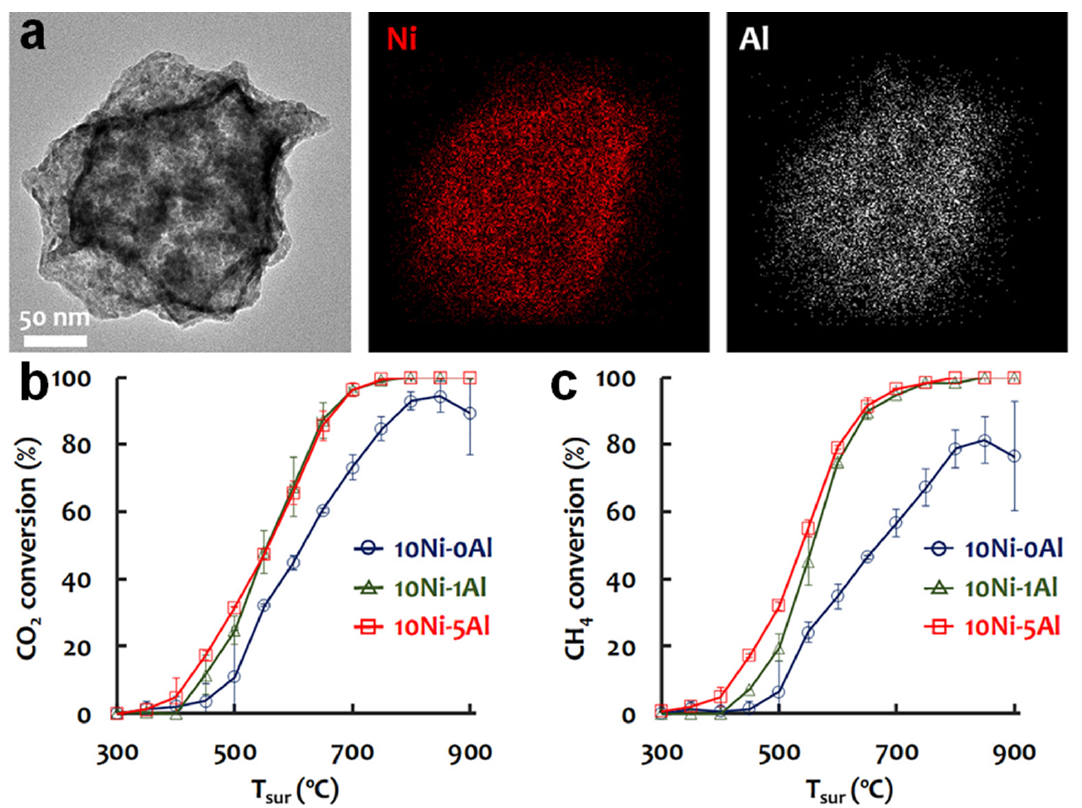
Figure 1. ( a ) HR-TEM image analysis of 10Ni-5Al with EDS elemental mapping. The scale bars are 50 nm. Activity tests of the catalysts using Ni-Al 2 O 3 ( b ) X CO2 vs. T sur ; ( c ) X CH4 vs. T sur . Reproduced with permission from [33]. Copyright 2020, Elsevier.